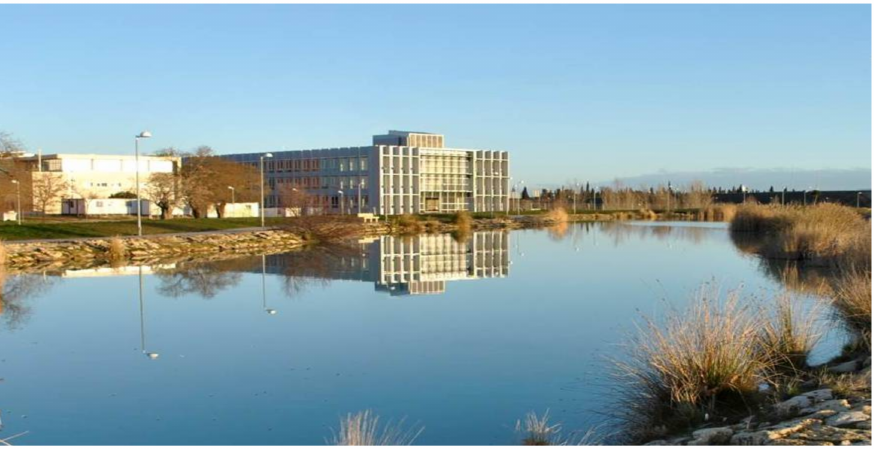
Figure 1. LUCIA near Zero Energy Building (nZEB), Valladolid,